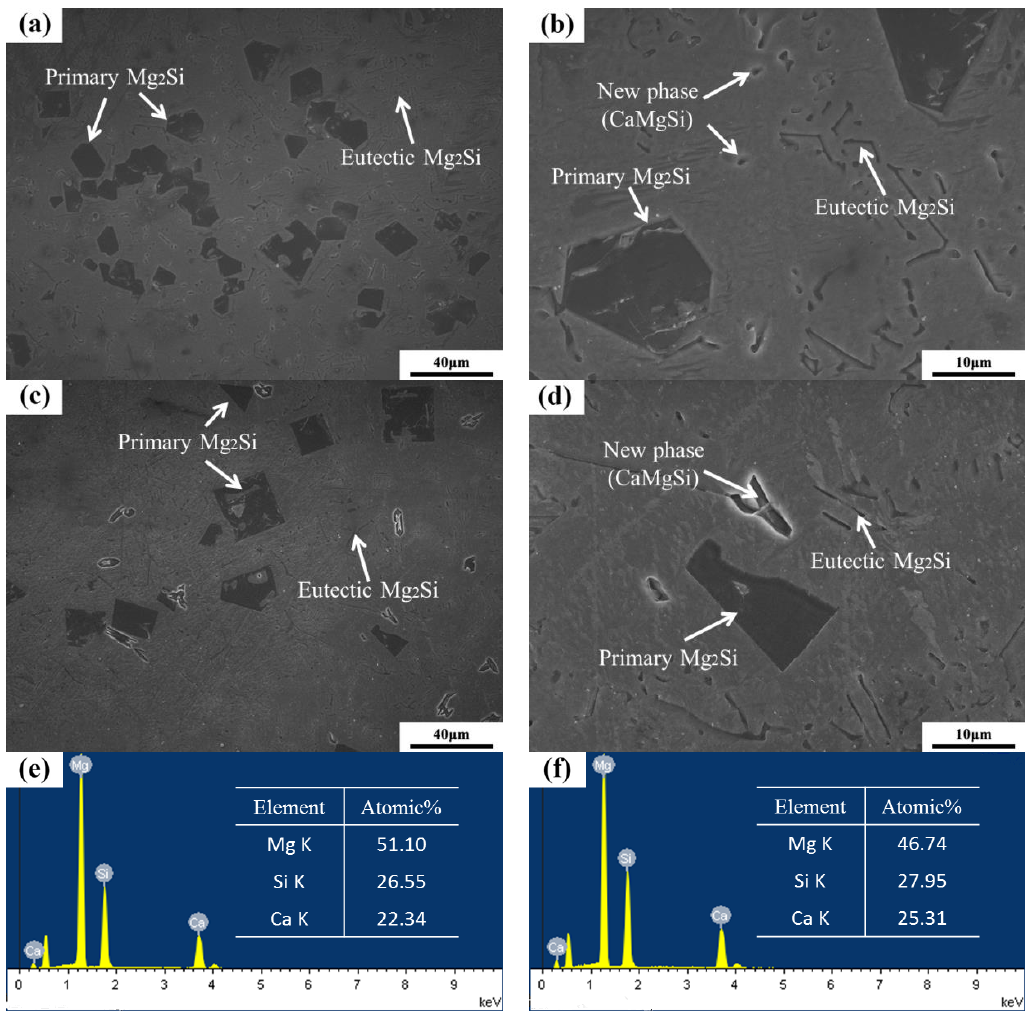
Figure 8. SEM images of Mg – 4Si – 0.8Ca and Mg – 4Si – 1.0Ca: ( a , b ) 0.8 wt.% Ca; ( c , d ) 1.0 wt.% Ca; ( e ) EDS of the new phase in the 0.8 wt.% Ca; ( f ) EDS of the new phase in the 1.0 wt.% Ca.